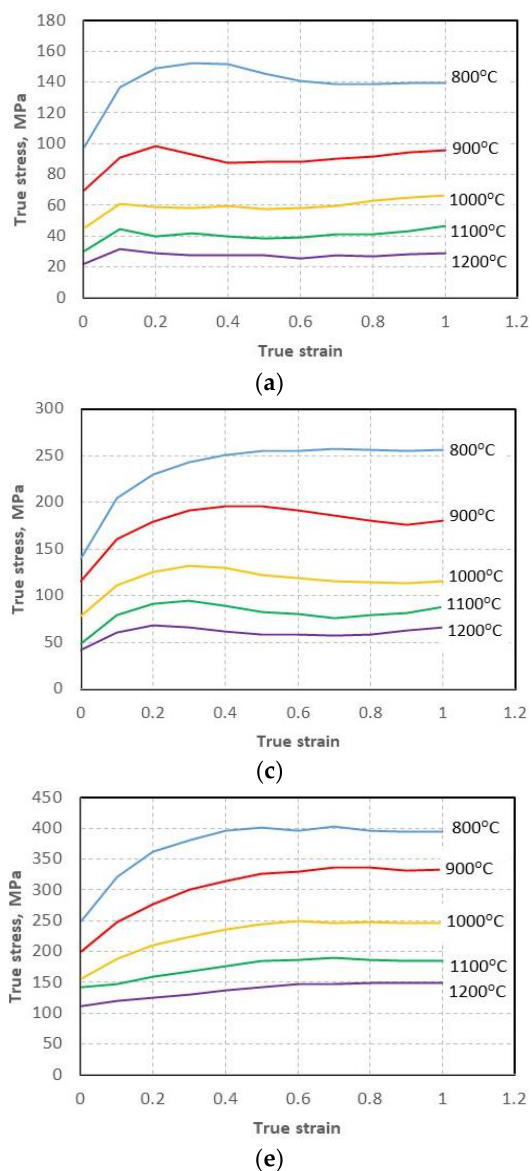
Figure 2. The true stress-true strain curves for the investigated 4130 steel deformed in compression at the true strain rate of 0.01 s − 1 ( a ), 0.1 s −1 ( b ), 1 s −1 ( c ), 10 s −1 ( d ), 100 s −1 ( e ).